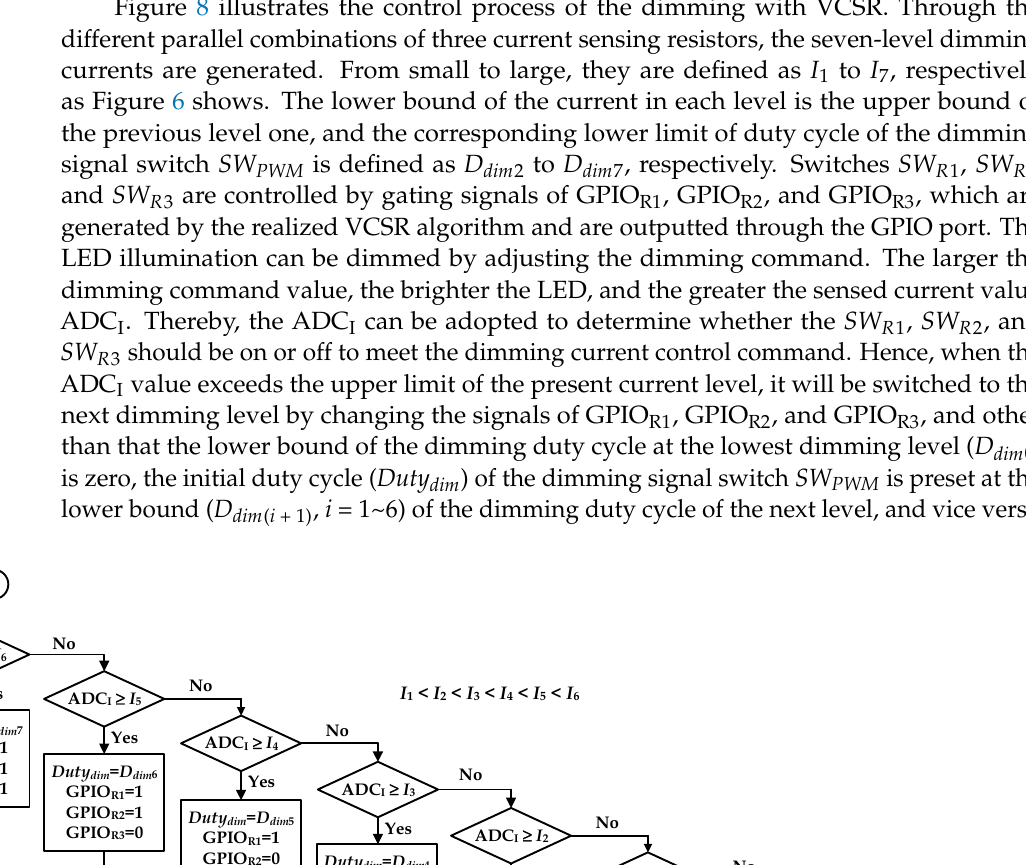
Figure 7. Scheme of the dimming with the VCSR method.